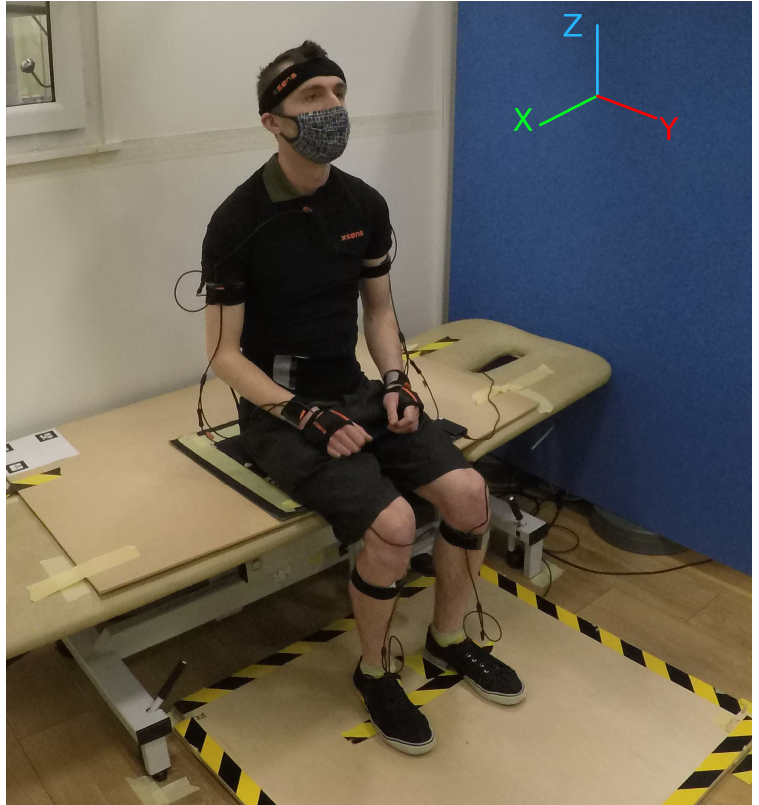
Figure 1. Participant wearing XSens suit, seated on the sensor mat attached to a rigid board on an adjustable plinth, with feet placed on the balance board. This setup shows the seat at 115% knee height. Reference frames are shown for guidance on the following methods and results. Yellow and black tape in the middle of the balance board was to help the participants stand near the centre, although they were allowed to move their feet at will to keep themselves balanced and comfortable.